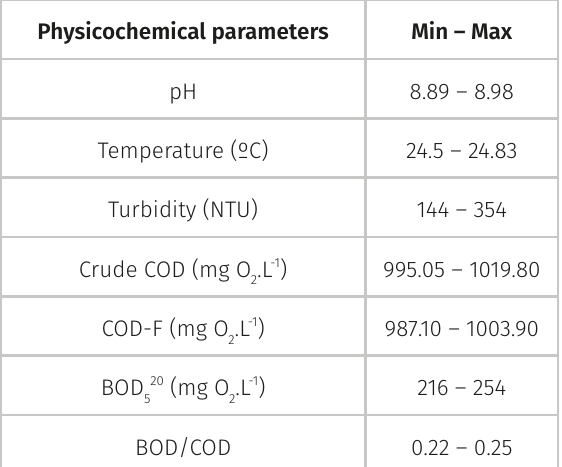
Table V . Physical-chemical characterization of the crude leachate collected on June 21, 2017 at the municipal landfill of Campo Mourão,